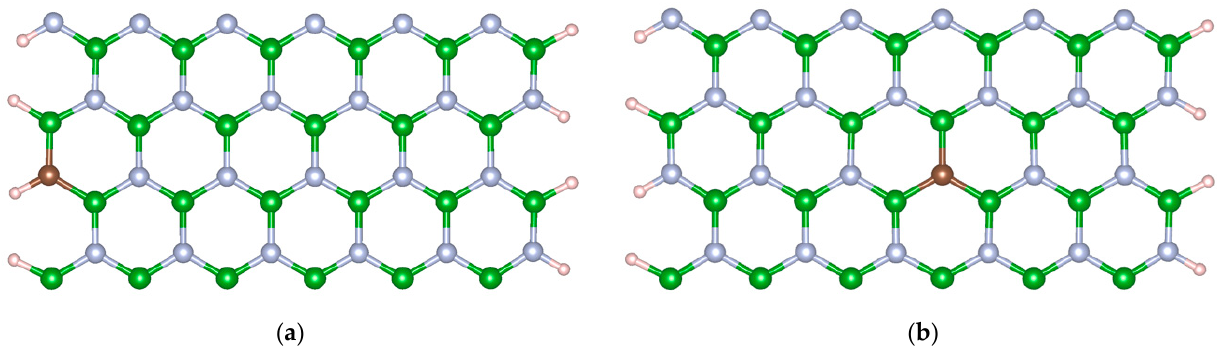
Figure 1. Schematic representations of ( a ) E_M ‐ BNNR and ( b ) C_M ‐ BNNR. The green sphere represents the B atom, grey sphere N atom, brown sphere C atom, and pink sphere H atom.